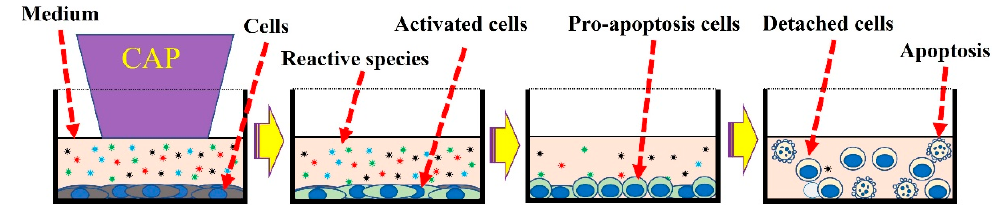
Figure 3. Schematic illustration of a typical direct CAP treatment in vitro. Here, the feature of apoptosis is used to represent the cell death pathway. Compared with indirect CAP treatment, cell-based H 2 O 2 generation and activation phenomenon in direct CAP treatment drastically enhances the cytotoxicity on cancer cells when experimental conditions are the same.